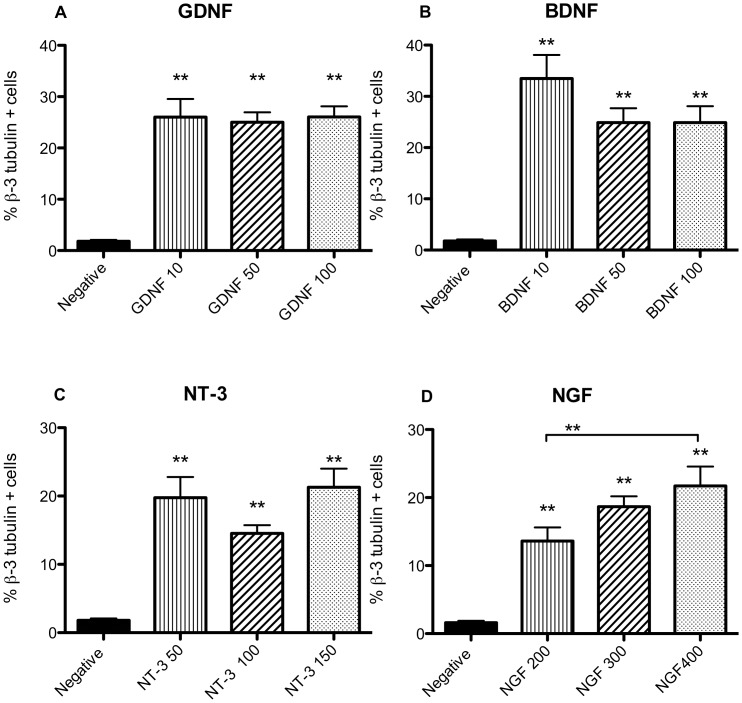
Percentage β-3 tubulin positive cells (Mean and SEM) under different neurotrophins conditions.Panel A: GDNF at 10, 50 and 100 ng/mL concentrations. Panel B: BDNF at 10, 50 and 100 ng/mL concentrations. Panel C: NT-3 at 50, 100 and 150 ng/mL. Panel D: NGF at 200, 300 and 400 ng/mL. The asterisks (**) represent statistically significant differences between the negative control and specific neurotrophin (p<0.01). The only significant difference between different concentrations of neurotrophins existed between NGF 200 and 400 ng/mL.